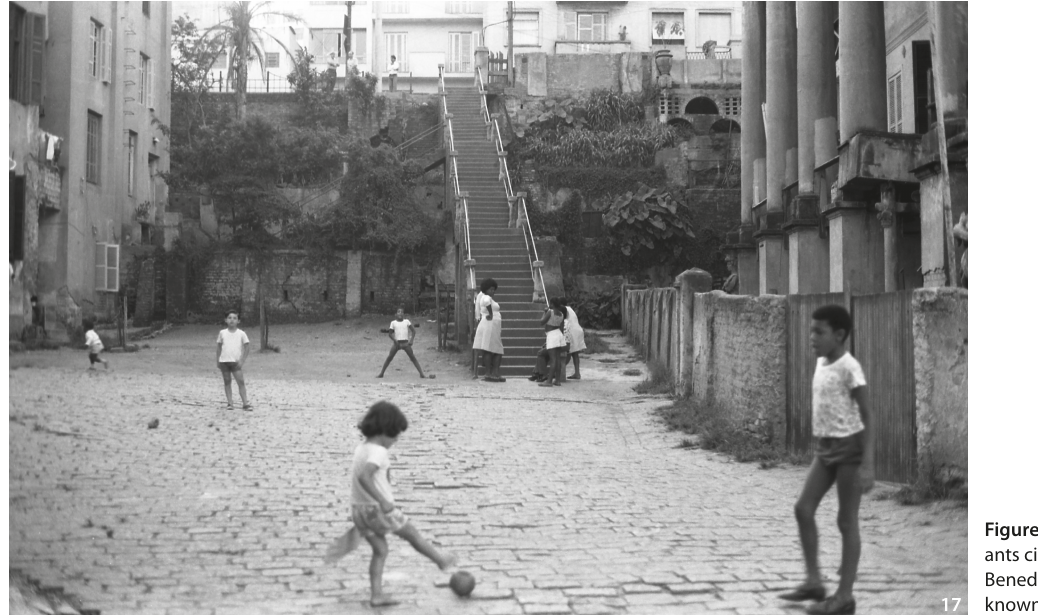
Figure 17 Vila Itororó ten- ants circa 1970 (Source: Benedito Toledo, date un-